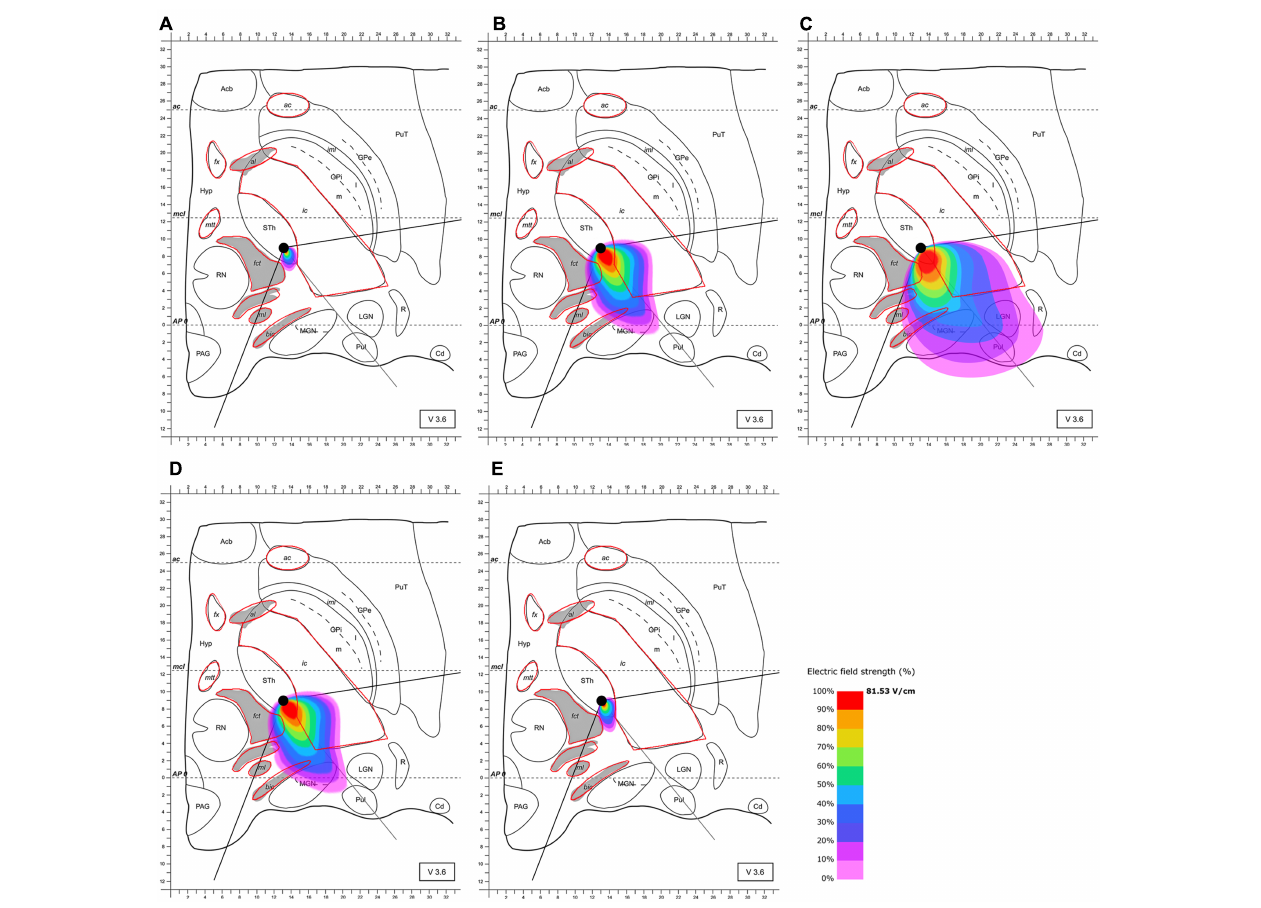
FIGURE 4 | Simulation of the electric field generated by segmented electrode stimulation through one active pole (130 Hz, 60 µ s and 2/3 mA) with the electrode lead rotated 128 ◦ counter-clockwise relative to the situation described in Figure 3 and positioned in the STN. Electric field distribution after (A) 10 µ s; (B) 40 µ s; (C) 60 µ s (maximal field extension); (D) 61 µ s and (E) 62 µ s; for abbreviations see Figure 1